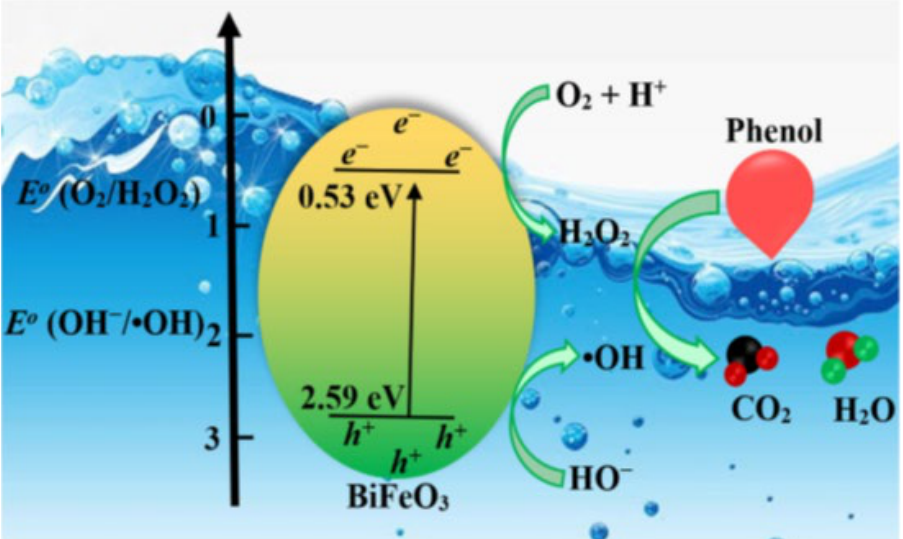
Figure 12. Mechanism of the phenol photocatalytic removal over BiFeO 3 under direct sunlight irradiation. Reproduced with permission from ref. [79]. Copyright 2022 Elsevier.